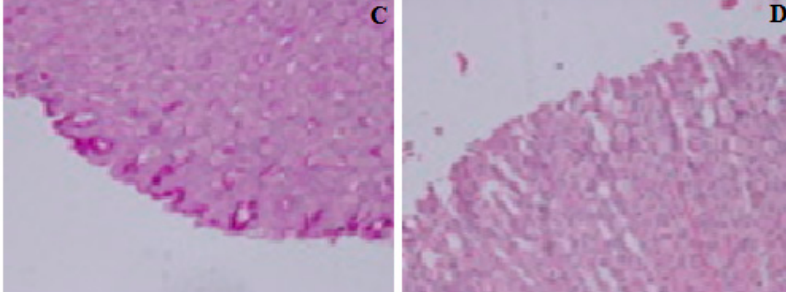
Figure 2. The ethanol-induced gastric ulcers after treatment with ( A ) normal control, ( B ) ethanol, ( C ) compound S3 (25.6 mg/kg) with ethanol and ( D ) indomethacin (25 mg/kg) with ethanol. PAS staining indicates the mucus secretion in the gastric glands.